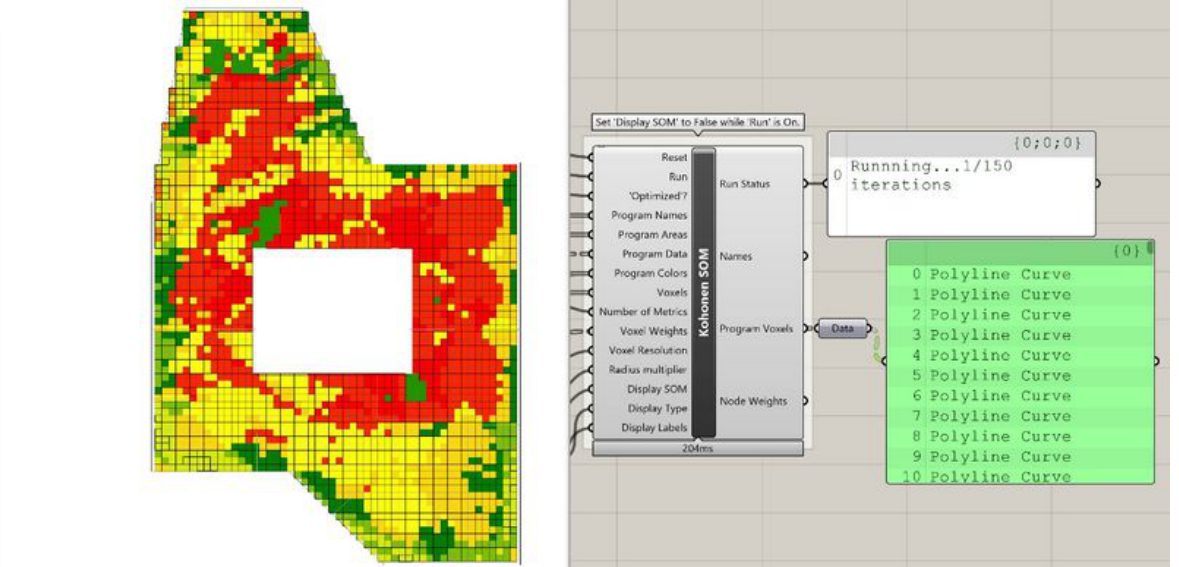
Figure 9. Interface of the Plan Bee library where we can a see a Kohonen self- organizing feature map (SOM) in action. From: Marco Juliani,